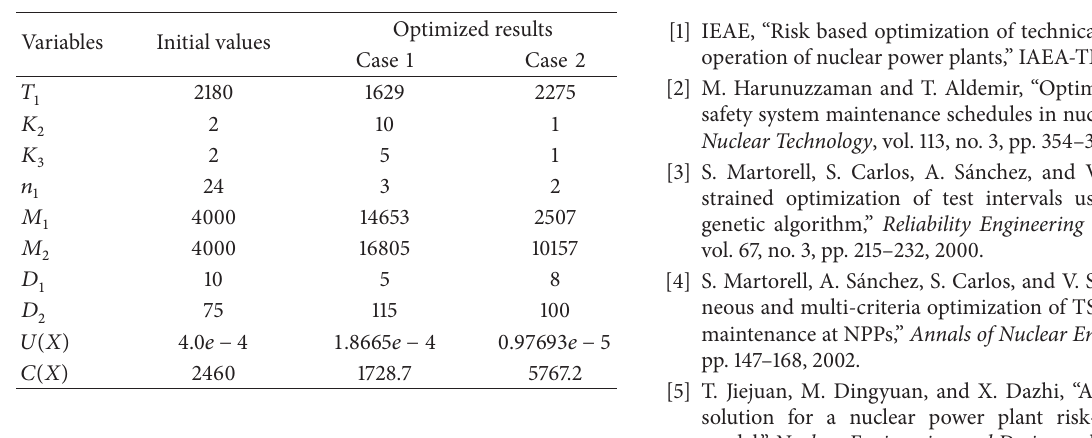
Table 8: Optimized